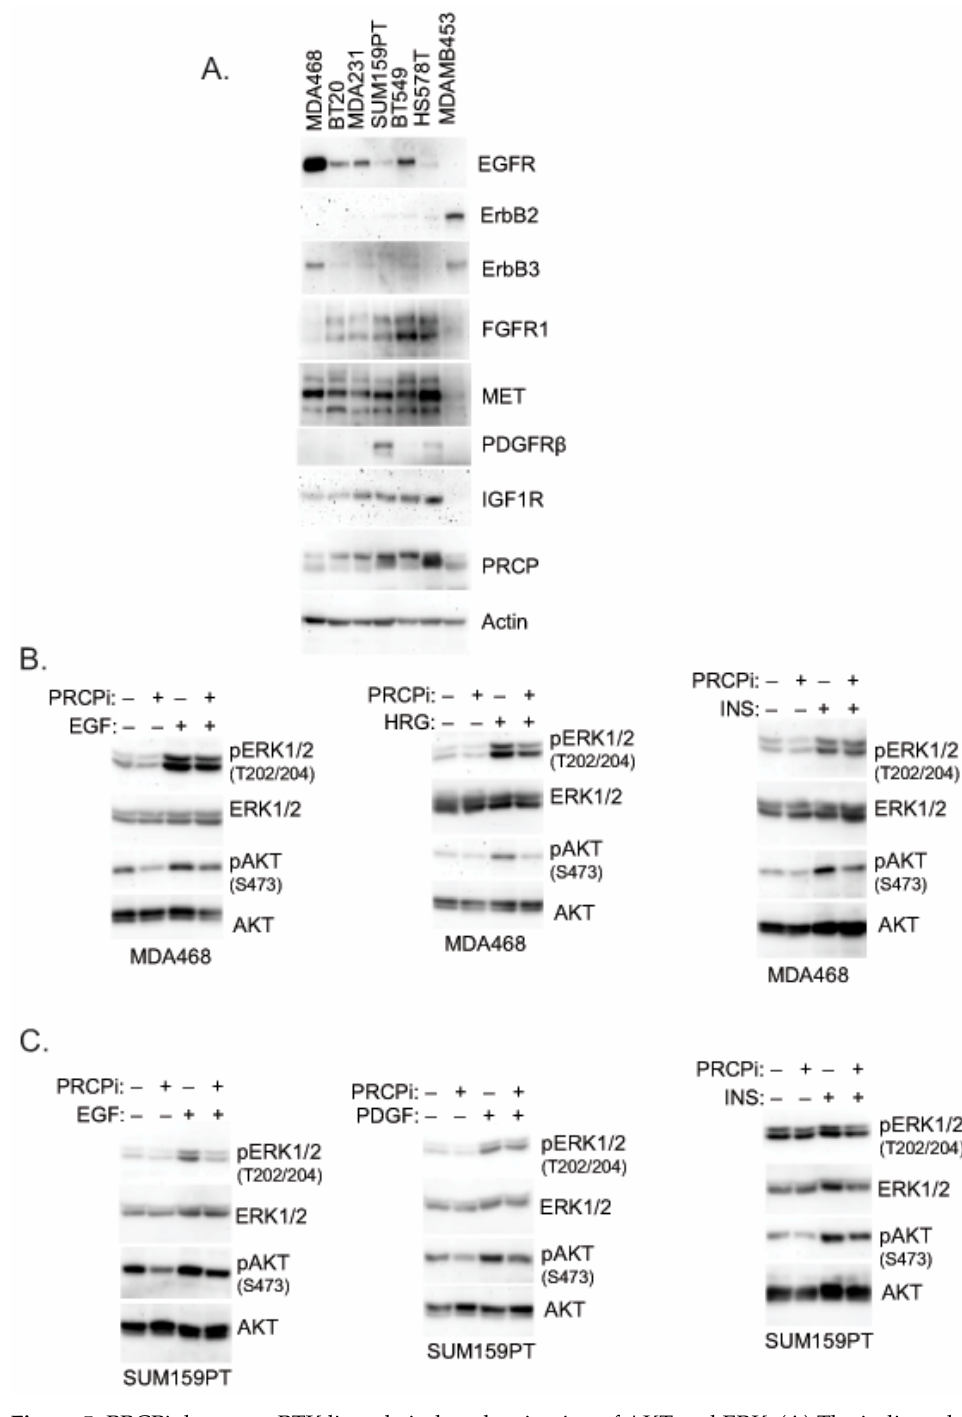
Figure 5. PRCPi decreases RTK ligands-induced activation of AKT and ERK. ( A ) The indicated cell lines were serum-starved overnight, and lysates blotted for the indicated proteins. MDA468 cells ( B ) and SUM159PT cells ( C ) were serum-starved overnight and then treated with EGF (50 ng/mL), Heregulin b1 (HRG, 50 ng/mL), insulin (INS, 50 ng/mL), or PDGF-BB (50 ng/mL) for ten minutes. Lysates were immunoblotted for the indicated proteins. Original Western Blots and densitometry can be found at Figure S7–S9.